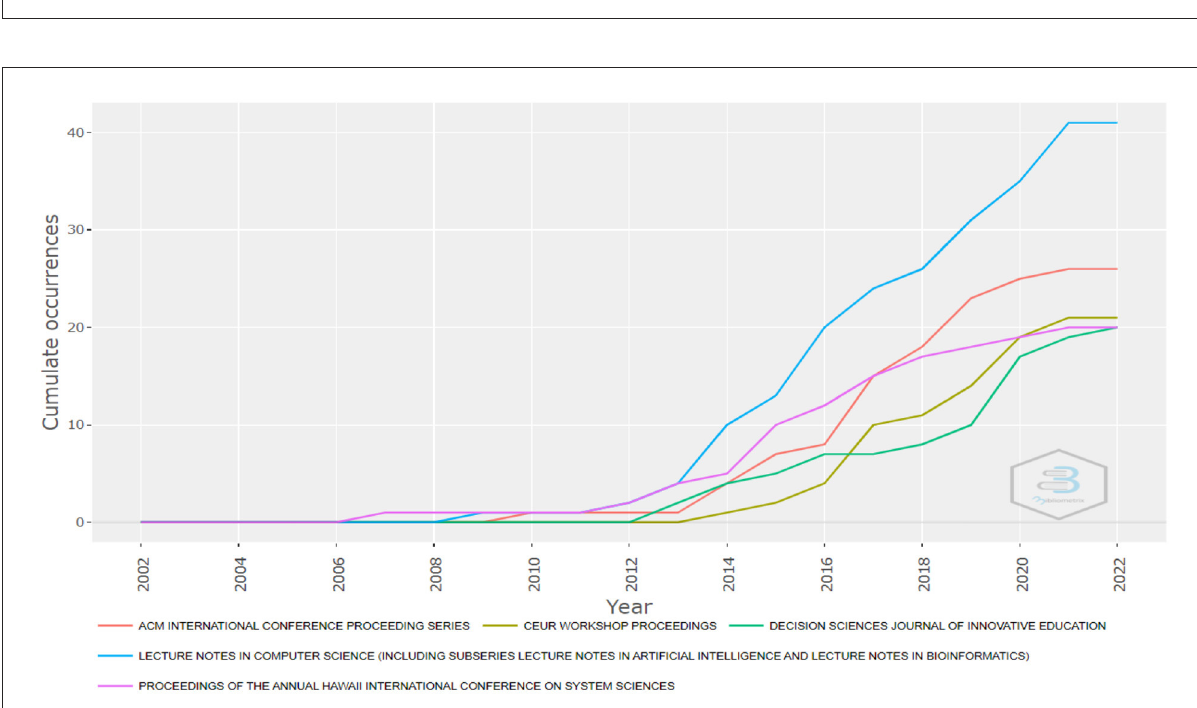
FIGURE7 Growth of publication sources. Source: Own elaboration using